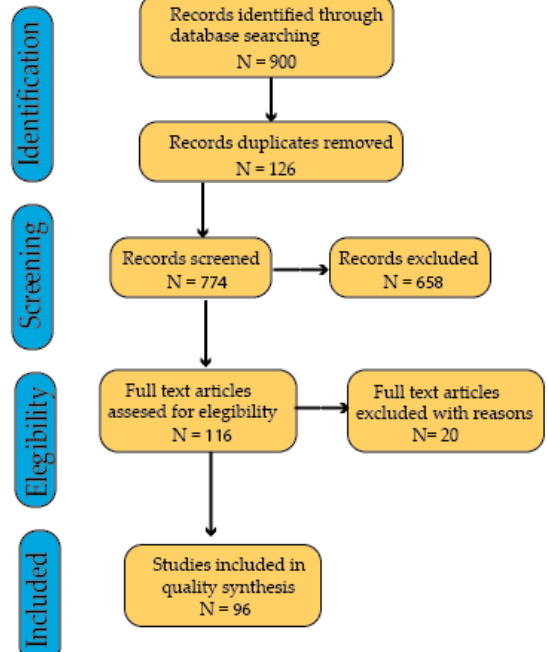
Figure 9. Methodology used for a systematic literature review and a qualitative analysis of LoRa- related papers.